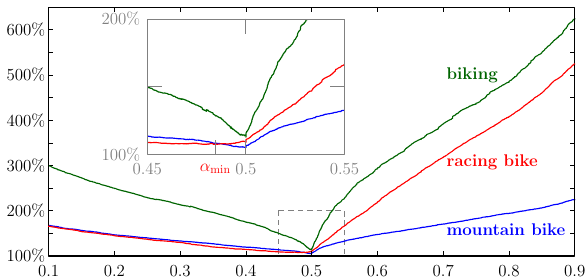
Figure 8. Number of milestones as a function of α , summed over all trajectories of the same type and measured in percent relative to the minimum number of milestones. The minimum is attained close to α = 0 . 485 for racing bike and at α = 0 . 5 for biking and mountain